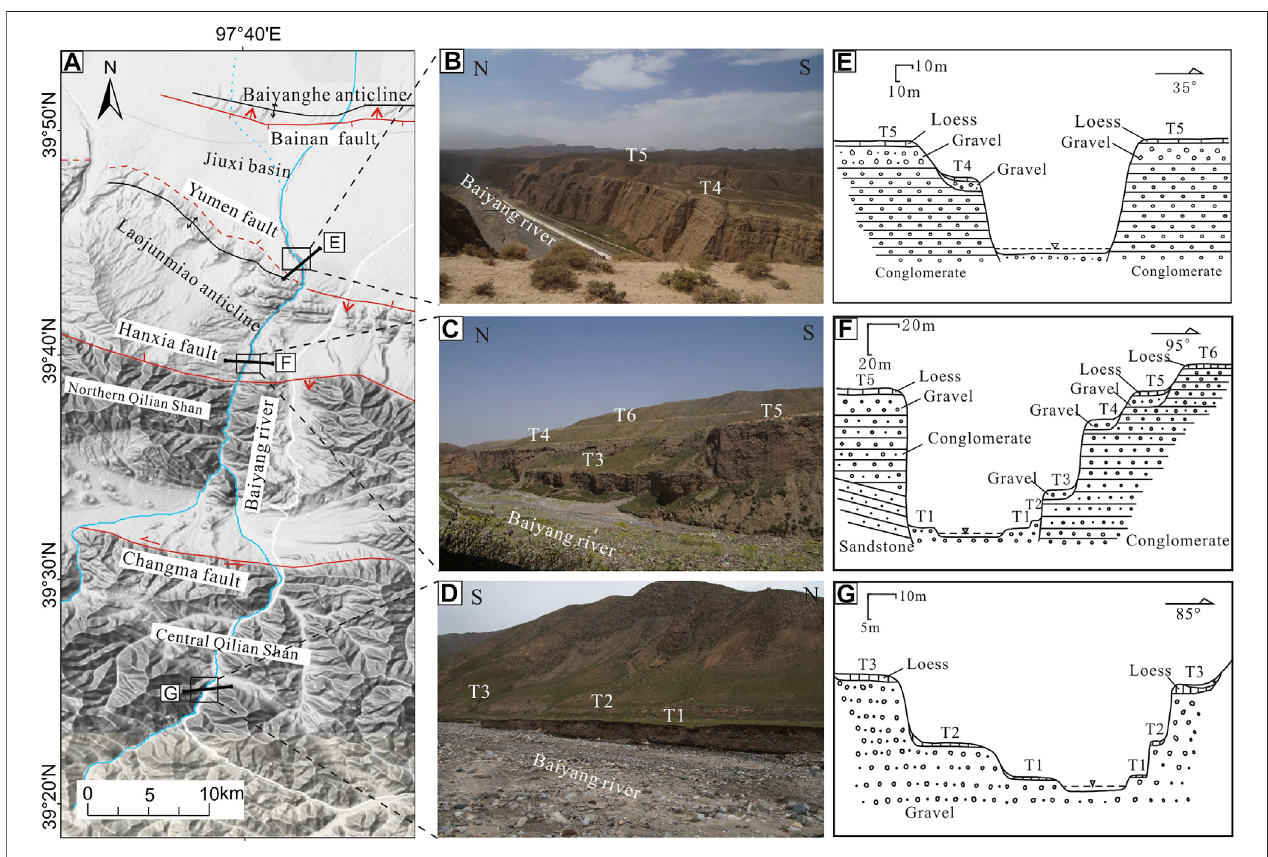
FIGURE 4 | (A) The topographic map of the Baiyang river catchment. The range of the map is shown in the white frame of Figure 2 . (B – D) are the regional terrace photographs of the lower, middle and upper reaches of the Baiyang river. Black rectangles of panel (A) show the locations of these photographs. (E – G) are the representative geologic transects of river terraces of the lower, middle and upper reaches, showing the terrace levels and the composition of terraces. The thick black lines in panel (A) denote the positions of these transects (modi fi ed from Chen and Koronovskii, 2020).